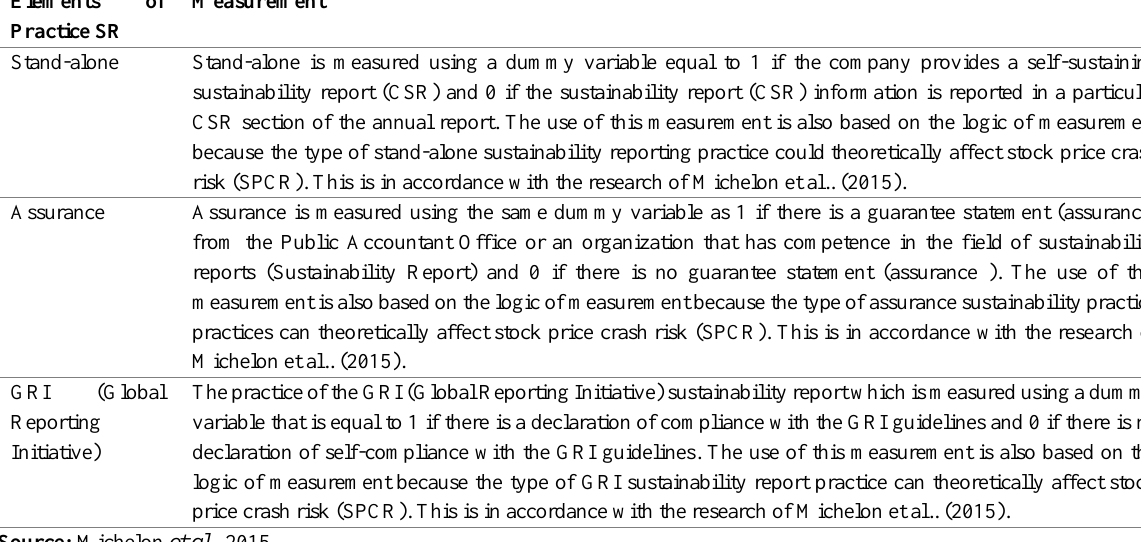
Table 2: Measurement of sustainability report